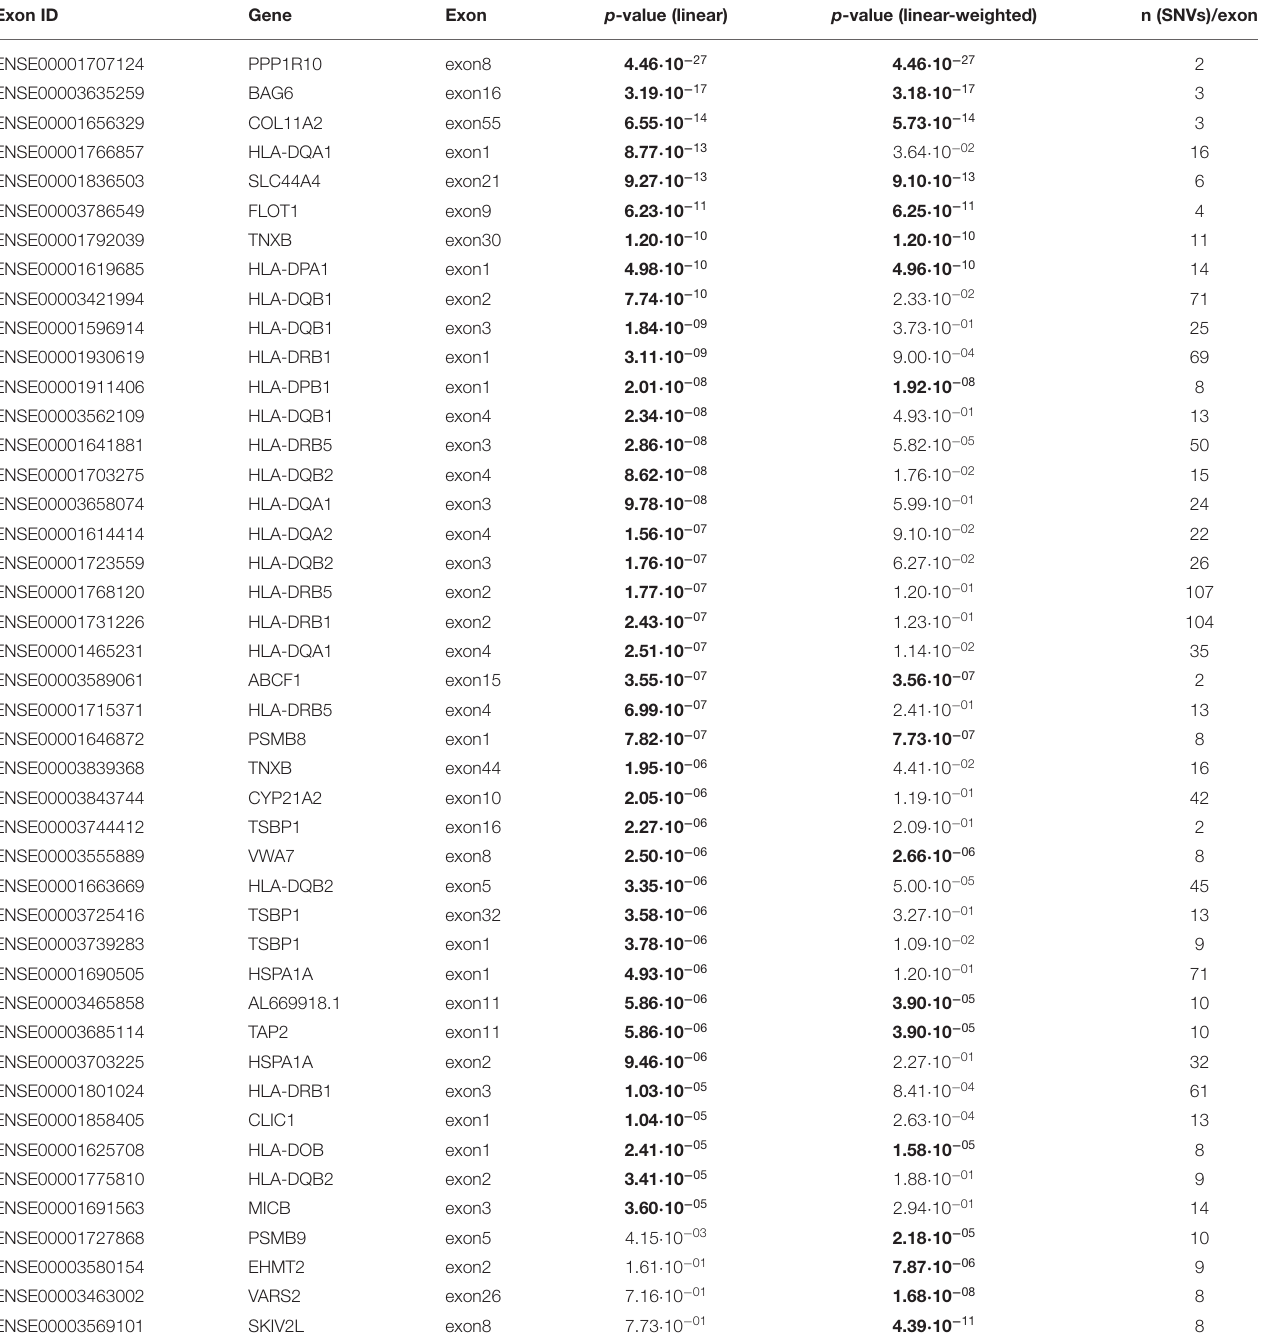
TABLE 2 | List of exons found to be significantly associated with NDR-defined T1D using the linear as well as the linear-weighted SKAT kernel, after Bonferroni correction for 1,209 tests. Exon ID